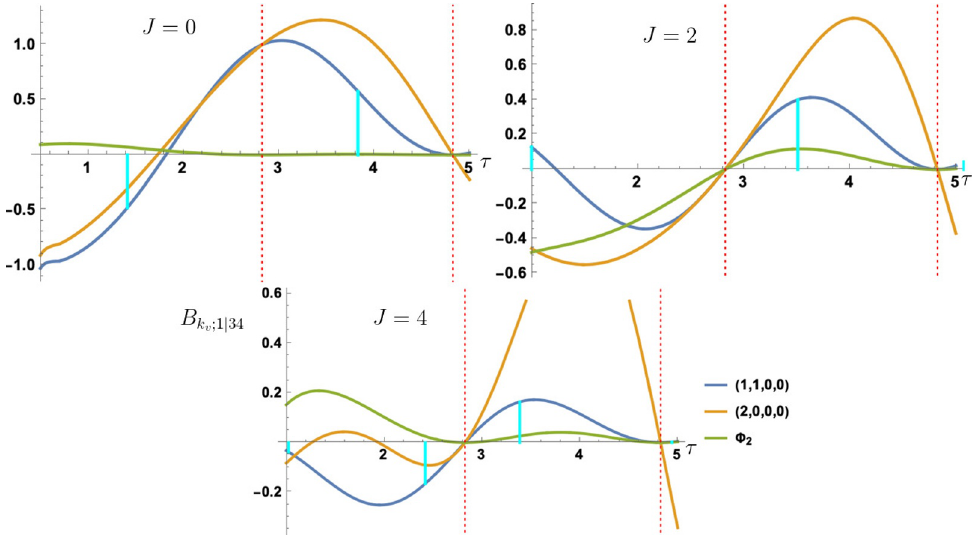
for the h (cid:15)(cid:15)(cid:15)(cid:15) i acting on conformal blocks G of different spin J , twist Figure 7 . Action of B ∆ ,J k ;1 | 34 τ = ∆ − J and subtraction schemes k = (1 , 1 , 0 , 0) and (2 , 0 , 0 , 0) represented as blue and orange curves respectively. Red dotted vertical lines denote double-twist values while vertical cyan lines denote the Ising model operators appearing in the OPE of h (cid:15)(cid:15)(cid:15)(cid:15) i .